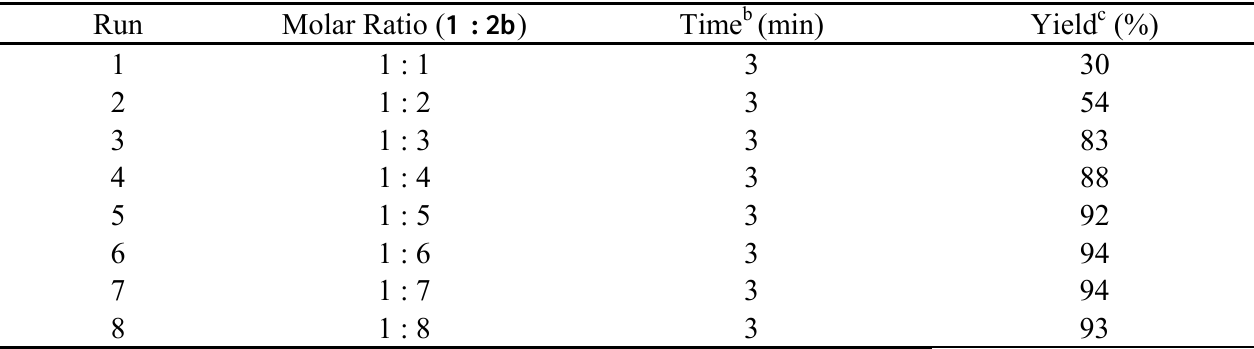
Table 4. Optimization of the molar ratio of ferulic acid to ethanol for the synthesis of ethyl ferulate ( 3b ) a